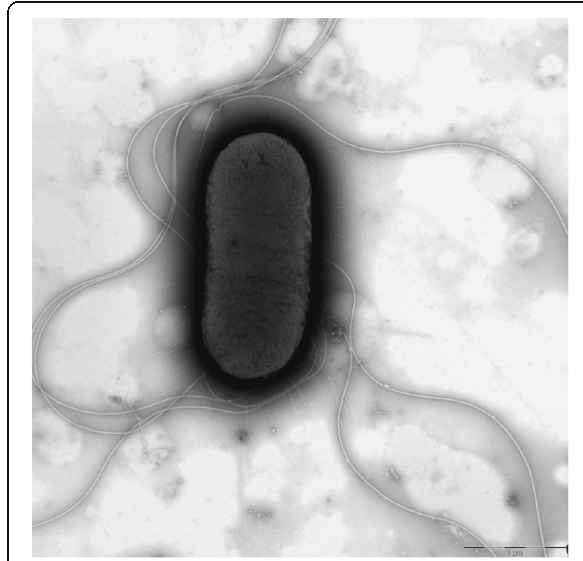
Fig. 1 Transmission electron micrograph of APEC_O2. The strain is a short to medium rod-shaped bacterium with a length of 1 – 2 μ m. It moves via peritrichous flagella. The magnification rate is 20,000×. The scale bar indicates 1 μ m